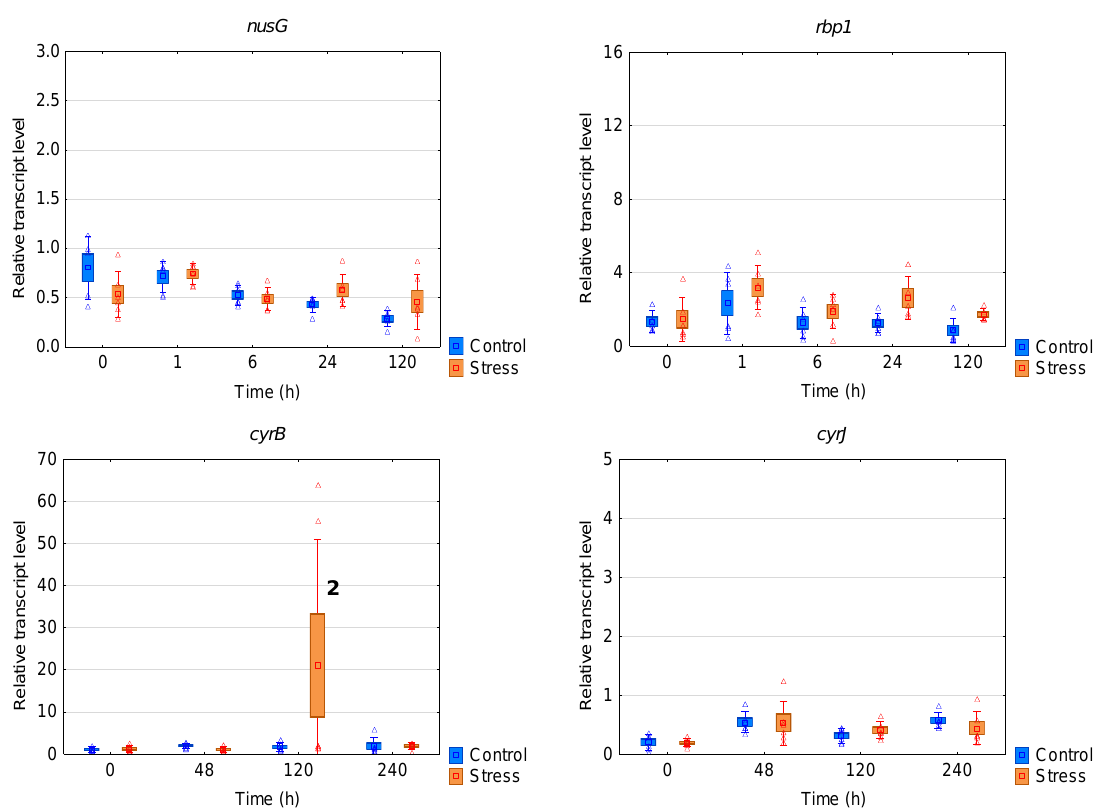
Figure 4. The box plots with a relative gene expression level of each analyzed gene of Raphidiopsis raciborskii CS-505 in reference to the prs house-keeping gene transcript level. Means are indicated by squares, bars represent the standard deviation whereas boxes represents the standard error. Raw data are marked as triangles. Statistically significant differences: (1) increased in comparison to stress t0 and control 120 h; (2) increased in comparison to each control and stress.